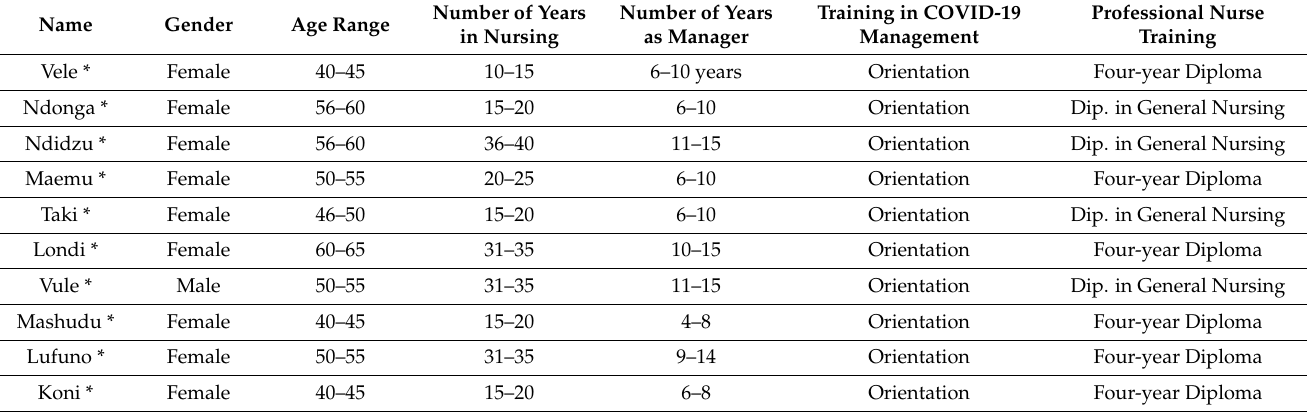
Table 1. Demographic characteristics of participants.